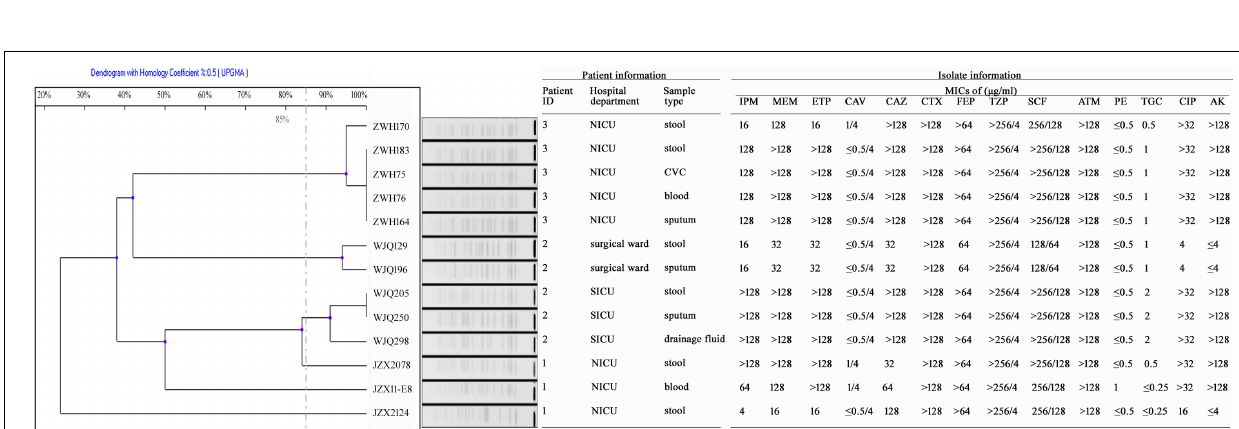
FIGURE 2 | Antimicrobial susceptibility and PFGE profiles of 13 CRKP isolates collected from three inpatients. IPM, Imipenem; MEM, Meropenem; ETP, Ertapenem; CAV, Ceftazidime-avibactam; CAZ, Ceftazidime; CTX, Cefotaxime; FEP, Cefepime; TZP, Piperacillin-tazobactam; SCF, Cefoperazone-sulbactam; ATM, Aztreonam; PE, colistin; TGC, Tigecycline; CIP, Ciprofloxacin; AK, Amikacin; CVC, central venous catheter.